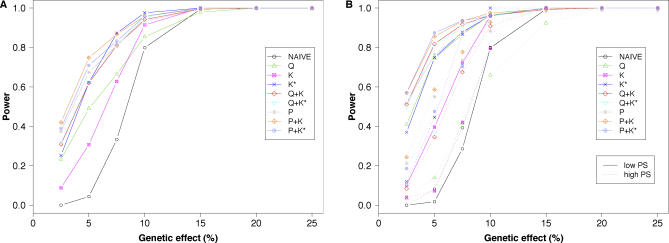
Power of the Different Methods to Detect a QTNThe power of the different methods to detect a QTN using a 5% significance level (based on the observed distribution of p-values), as a function of the fraction of the phenotypic variation attributable to the QTN.(A) Power averaged across all simulated QTN. Methods that reduce confounding more effectively have better power.(B) Power calculated separately for QTN that showed strong correlation with population structure (“high PS,” arbitrarily defined as simulations where more than 50% of the phenotypic variation could be explained by Q (note that “P” performs better than “Q” largely because of this definition) and those that did not (“low PS”). All methods are relatively powerless to detect QTN that are strongly correlated with population structure. Results for haplotypes were similar (Figure S3).